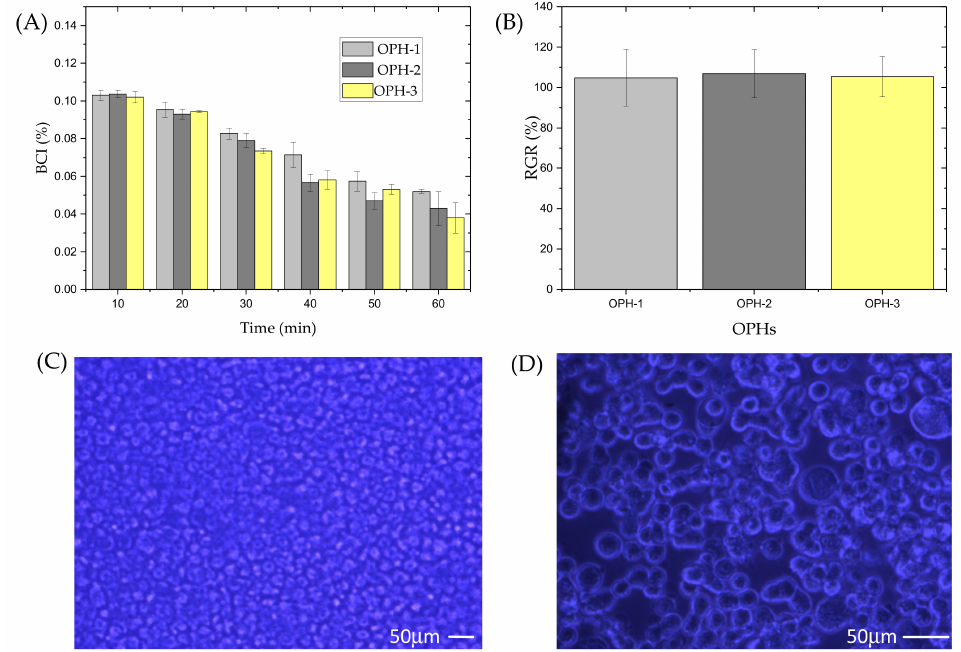
Figure 6. OPH samples blood coagulation performance, cell compatibility, and cytotoxicity. ( A ) BCI and ( B ) RGR of OPH-1, OPH-2, and OPH-3 (mean ± SD, n = 6). ( C ) Cell proliferation on the surface of OPH-3. ( D ) DAPI fluorescent staining of